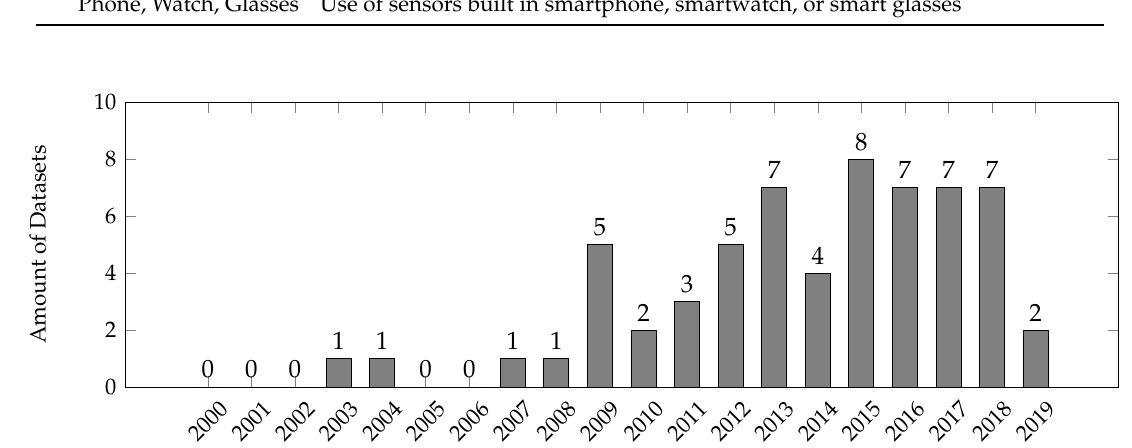
Figure A2. Datasets by year of